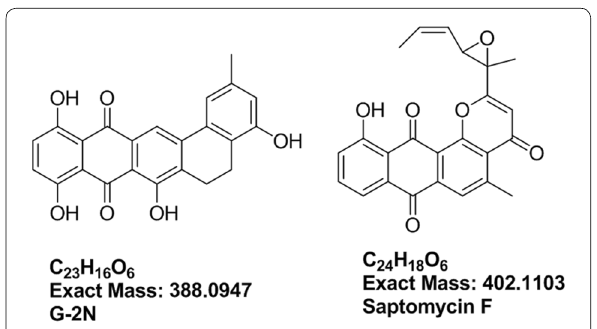
Fig. 1 Dereplicated structures from the active fractions: G‑2N and saptomycin